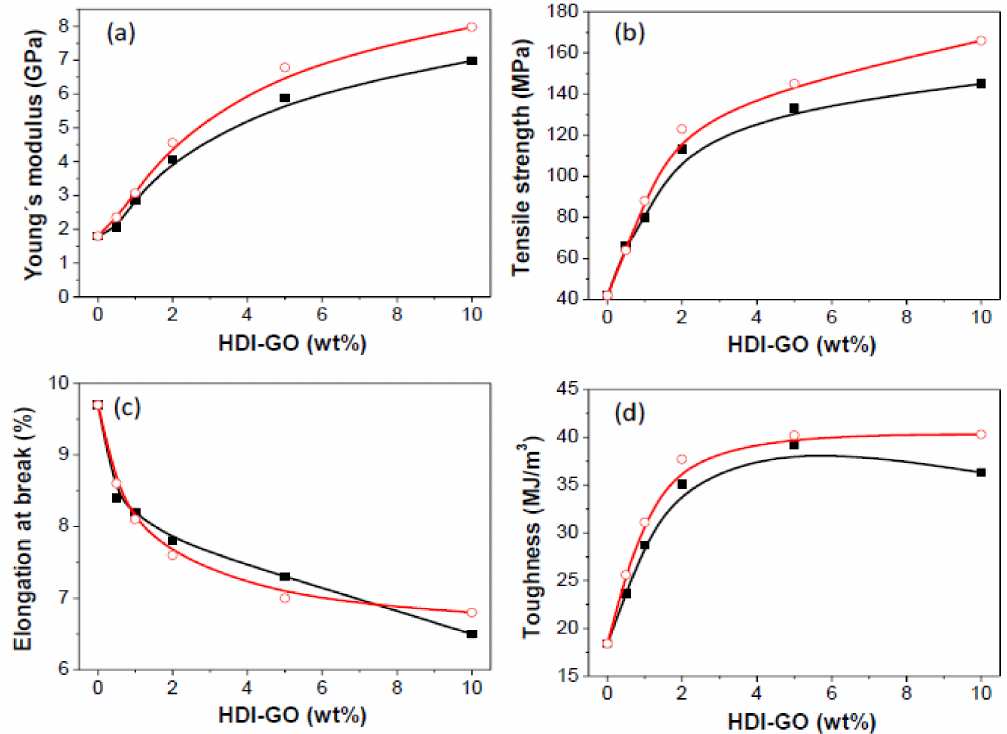
Figure 7. Mechanical properties of PEDOT:PSS nanocomposites reinforced with HDI-GO 6 ( open circles ) and HDI-GO 1 ( solid squares ) as a function of the HDI-GO content. ( a ) Young’s modulus; ( b ) tensile strength; ( c ) elongation at break; ( d )